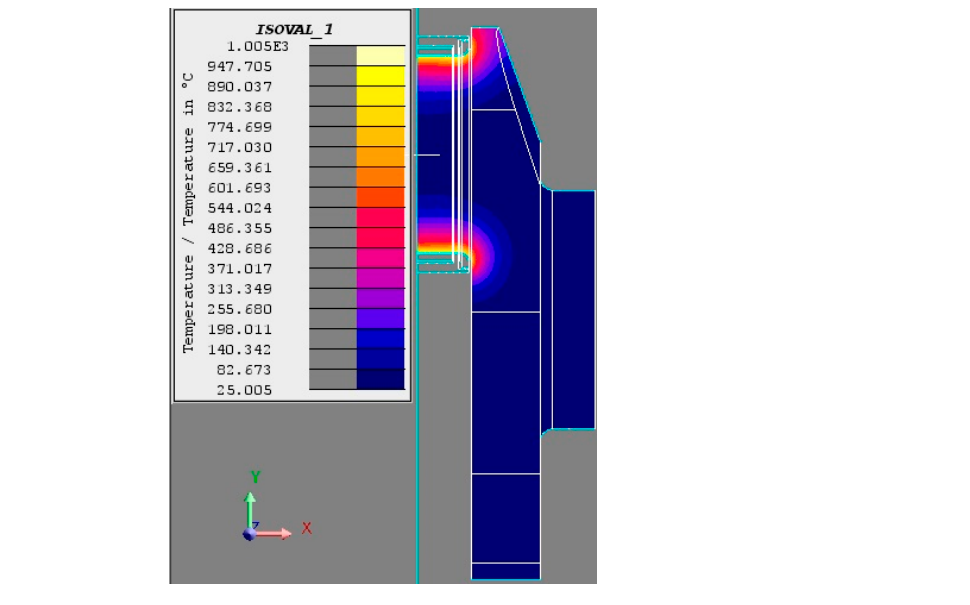
Figure 8. The evolution process of the temperature field during the heating stage (T = 9 s).